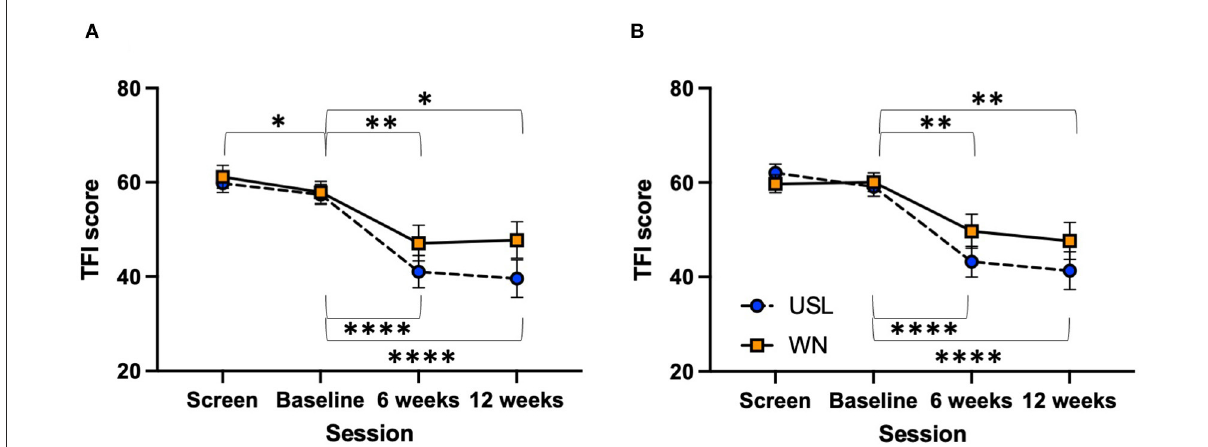
FIGURE5 TFI score across sessions. (A) Per-protocol. (B) Intent-to-treat. USL group (dashed line) WN group (solid line) ( * P < 0.05, ** P < 0.01, *** P < 0.001, **** P < 0.001). Mean scores and standard error bars are shown.